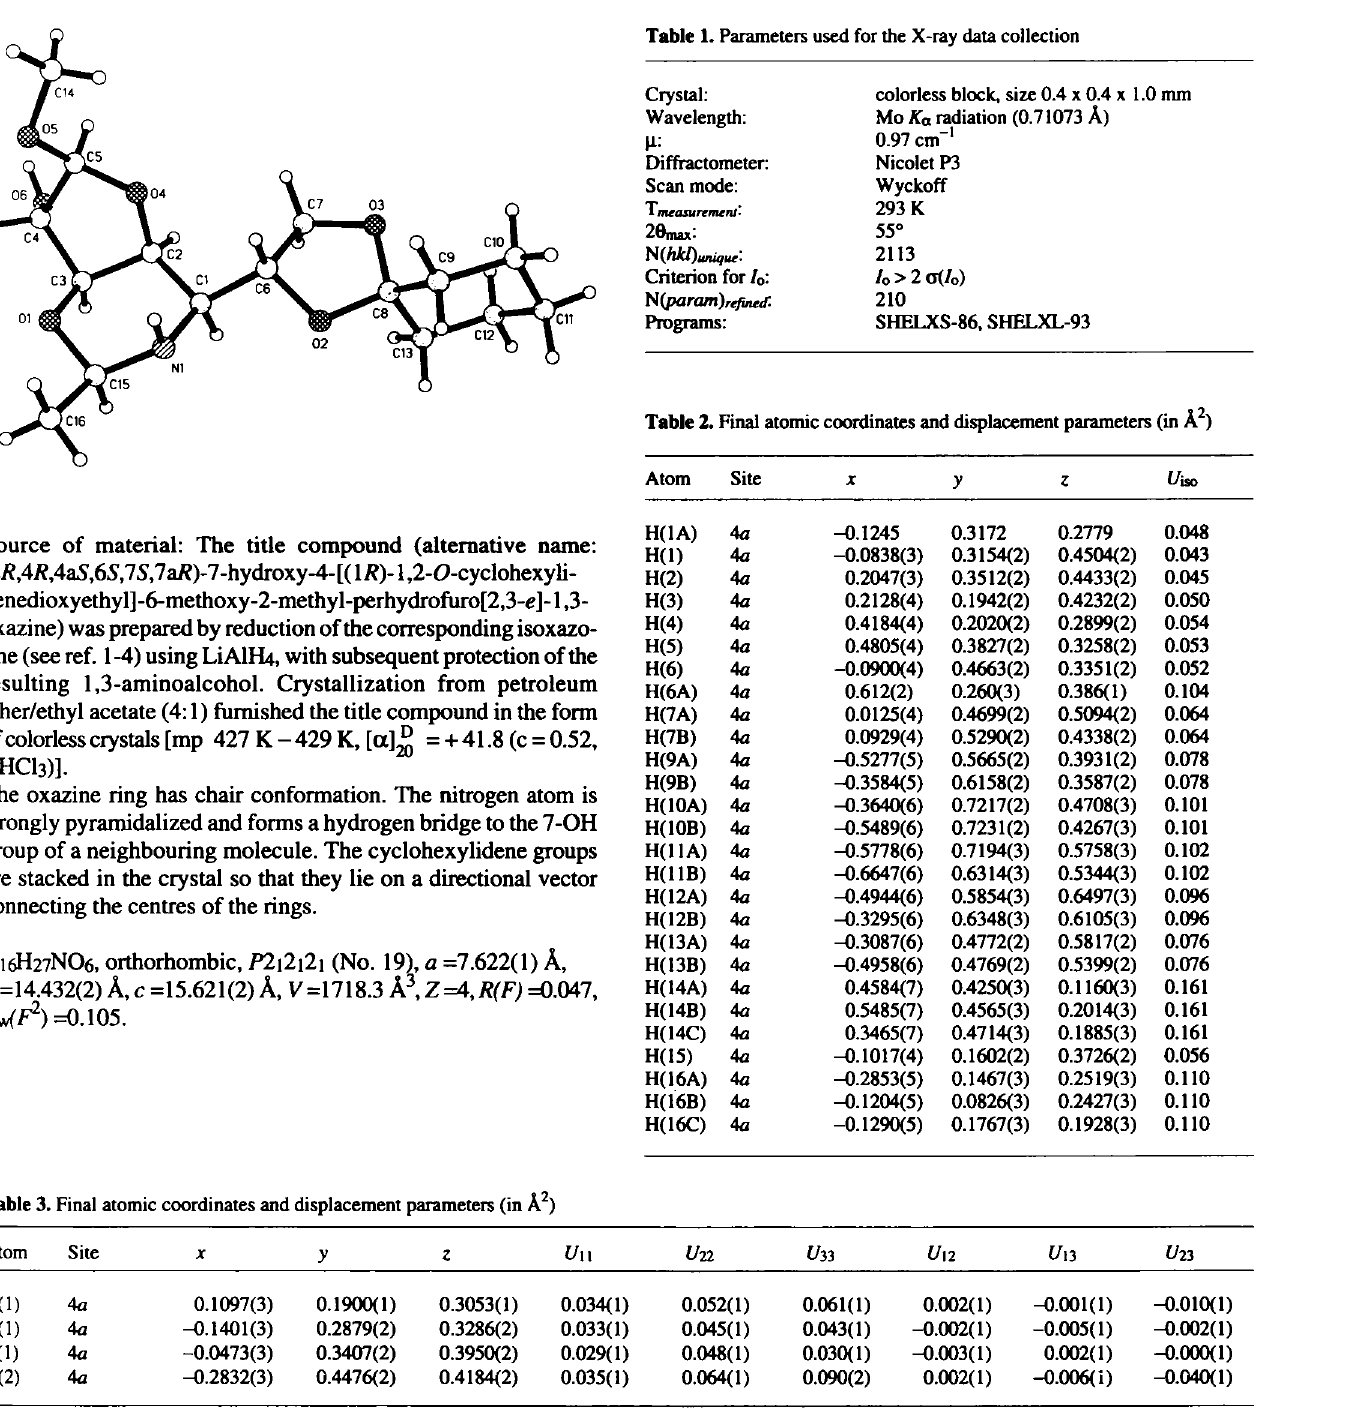
Table 3. Final atomic coordinates and displacement parameters (in